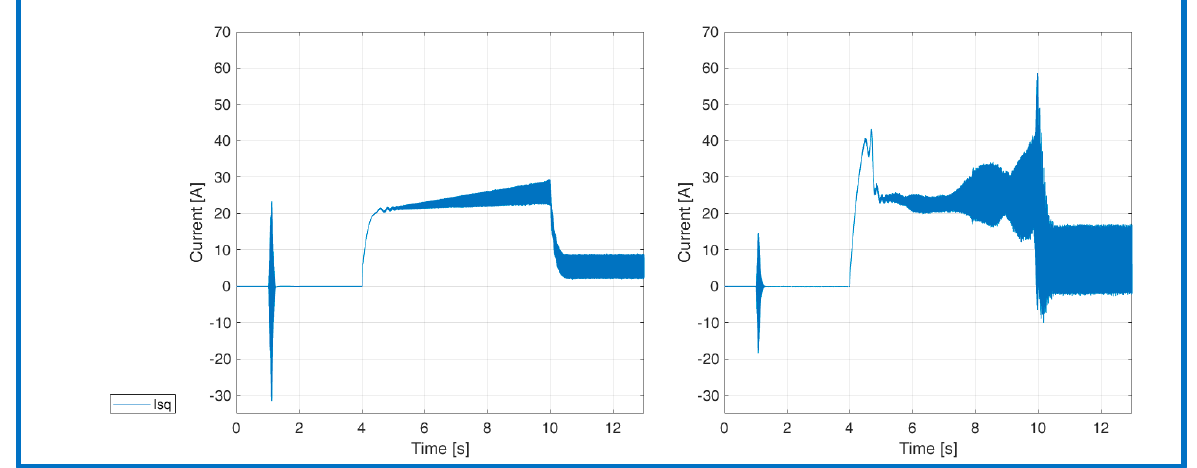
Figure 15. Stator current q-axis with ideal generators (left) and with inverter (right).